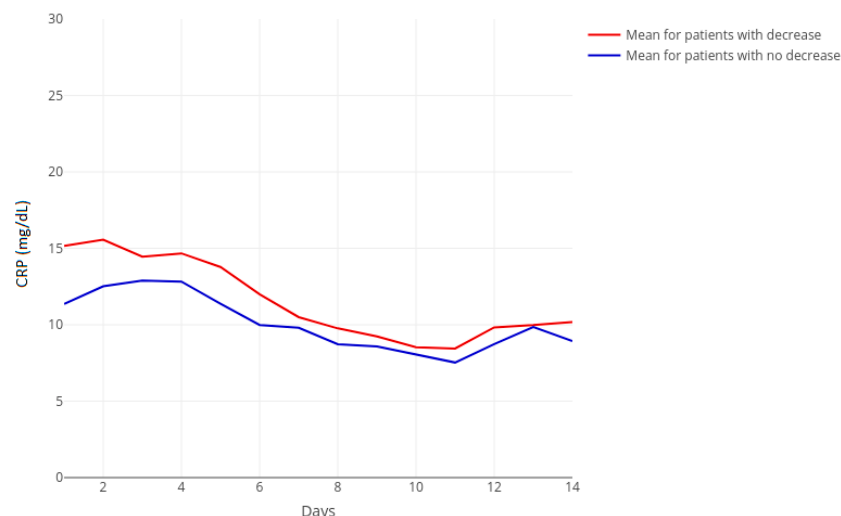
Figure 2. Temporal course of C-reactive protein (CRP) separated for decreasing (red, n = 59) and non-decreasing (blue, n = 71) groups with corresponding groupwise means. CRP reflects C-reactive protein. The horizontal axis represents days of treatment beginning at zero as the timepoint seven days before treatment. Day n represents the n th day of treatment.